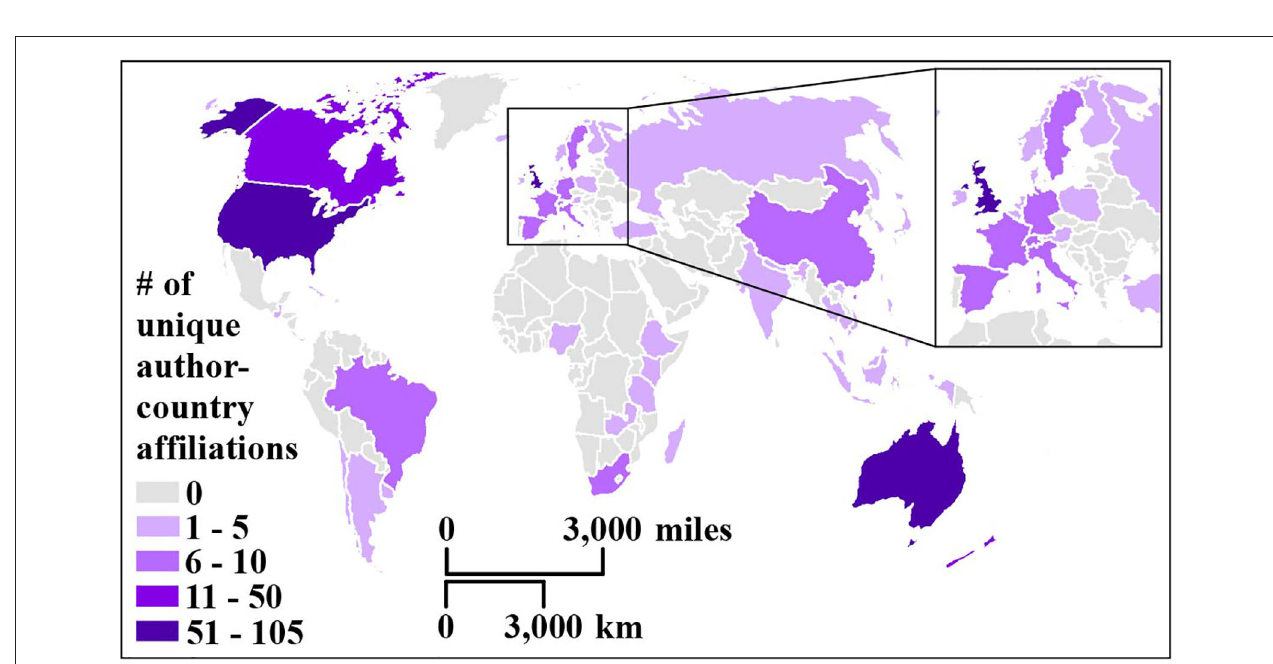
FIGURE 3 | Map of the number of author-country affiliations based on the unique country affiliations of all coauthors per publication. Inset map shows the United Kingdom, Ireland, and part of Northern Europe.